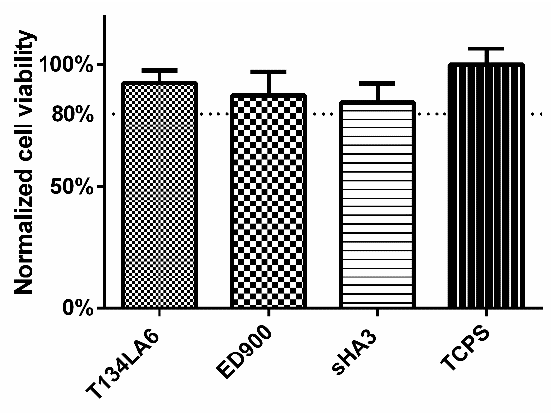
Figure 8. Direct-contact cytocompatibility of the different materials to L929 fibroblasts, normalized to TCPS control. Viability of the cells was determined after 24 h, using RotiTest ® Vital WST-8 assay. Film surfaces: T134LA6: unmodified macromer; ED900: surface coating with ED900 preincubated with soluble sHA3; sHA3: covalent ED900 and sHA3-coating; TCPS: tissue culture polystyrene. All values represent the mean ± SD of n ≥ 4.